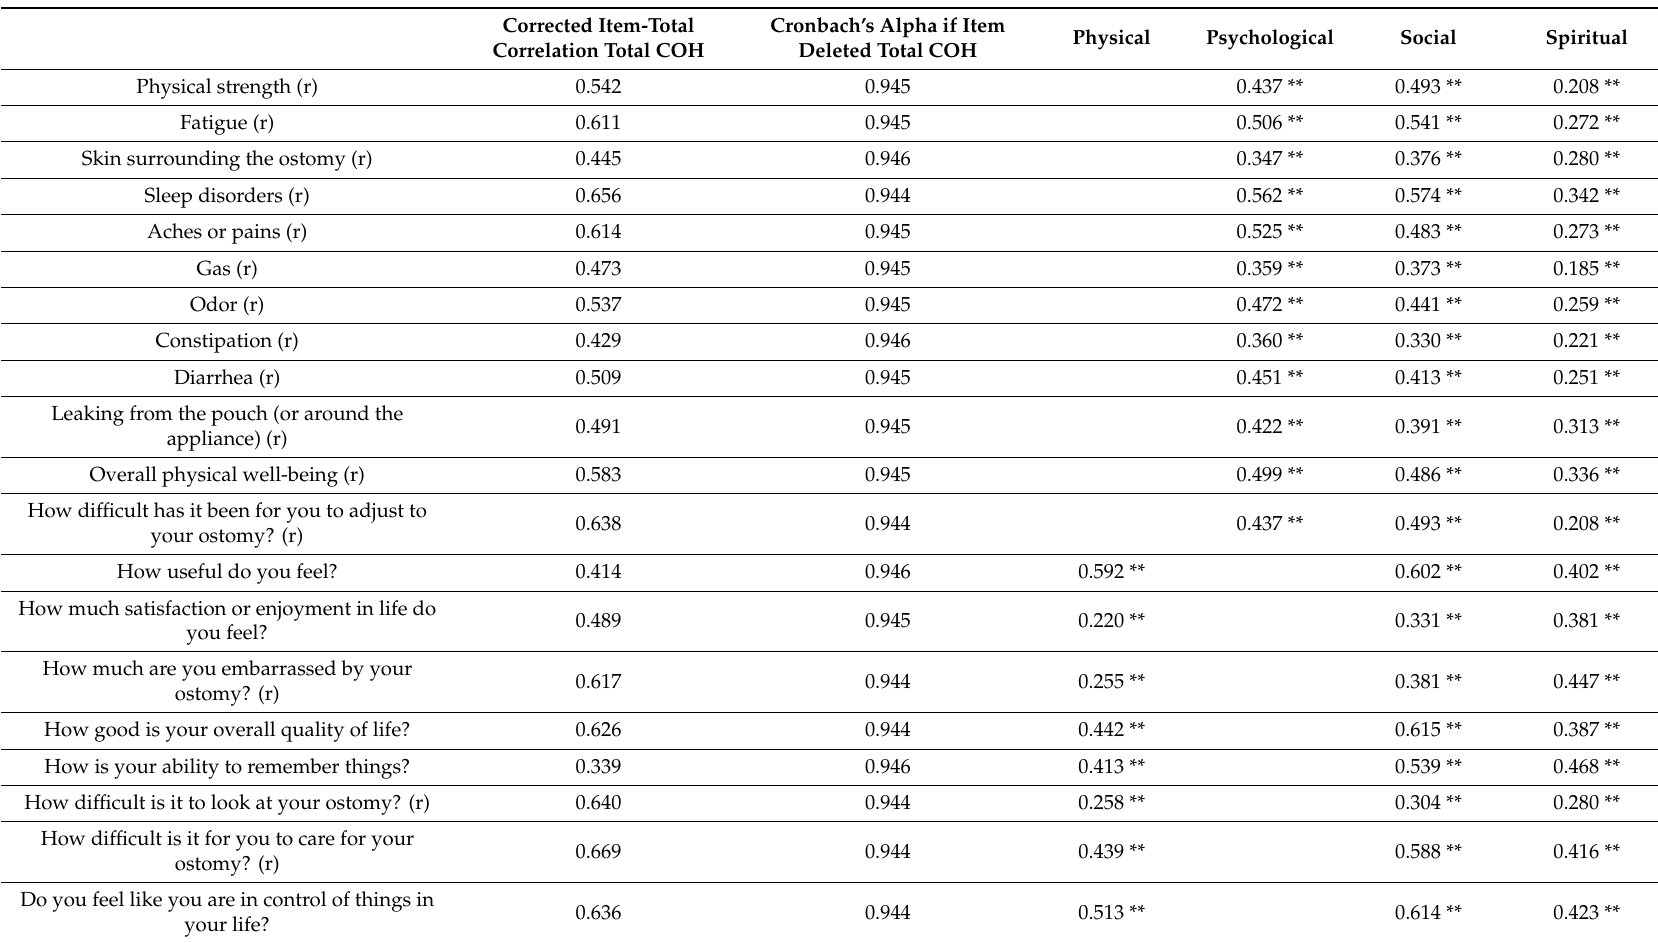
Table 4. Item-total correlation with total COH and each